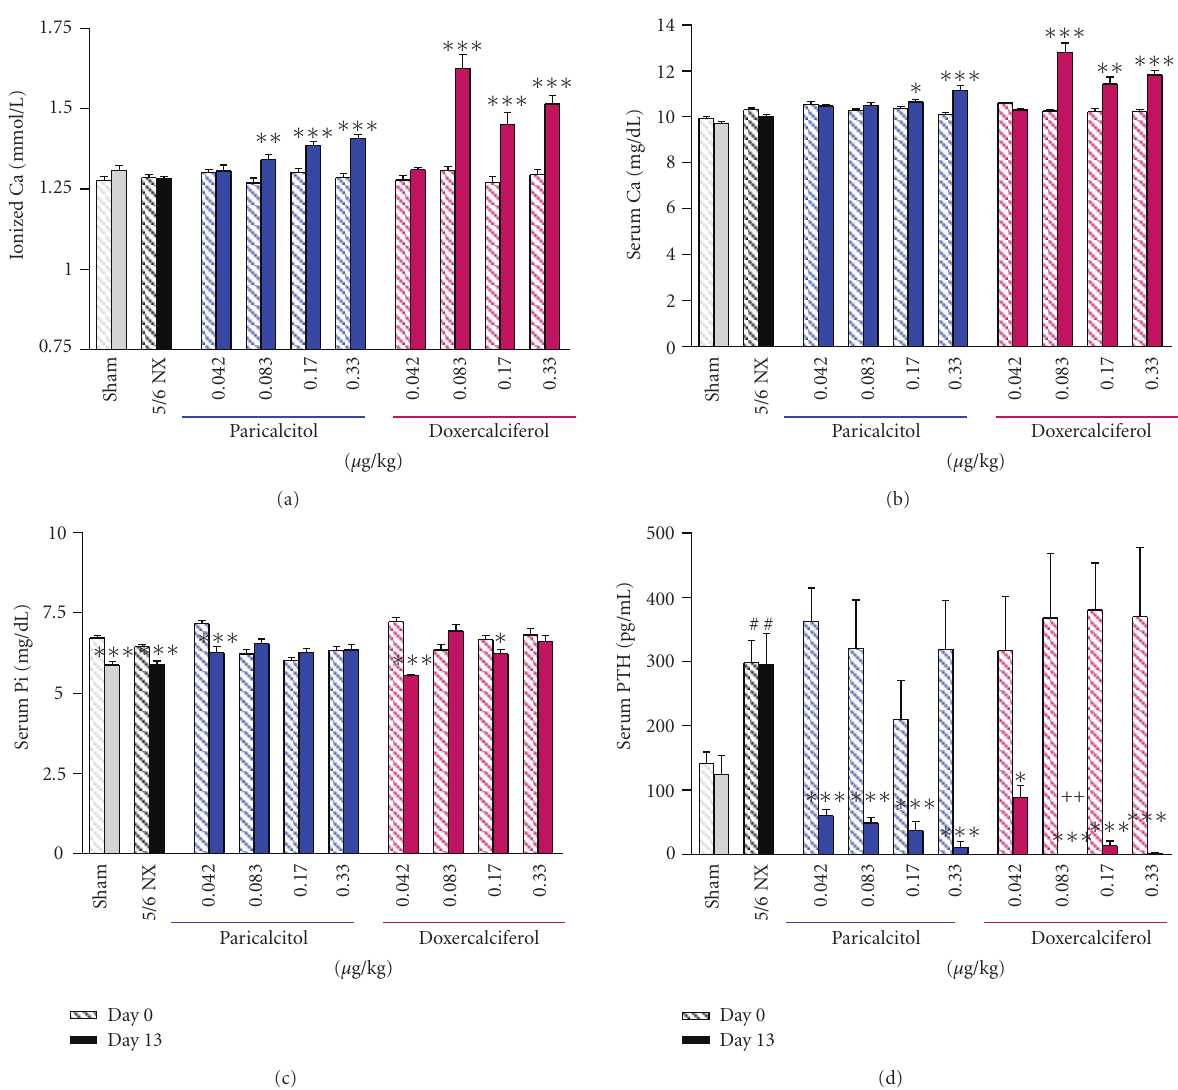
Figure 3: The ionized Ca, serum Ca, Pi, and PTH levels in uremic rats. Rats were treated as in Figure 2. Blood samples were collected for the measurement of ionized Ca, serum Ca, Pi, and PTH levels. Mean ± standard error was calculated for each group. Unpaired t-test with 95% confidence intervals of di ff erence was performed for statistical comparisons. ∗ P < . 05, ∗∗ P < . 01, ∗∗∗ P < . 001 versus Day 0 (before dosing at six weeks after the surgery). # P < . 05 versus Sham. ++ P < . 01 versus paricalcitol at the same dose.